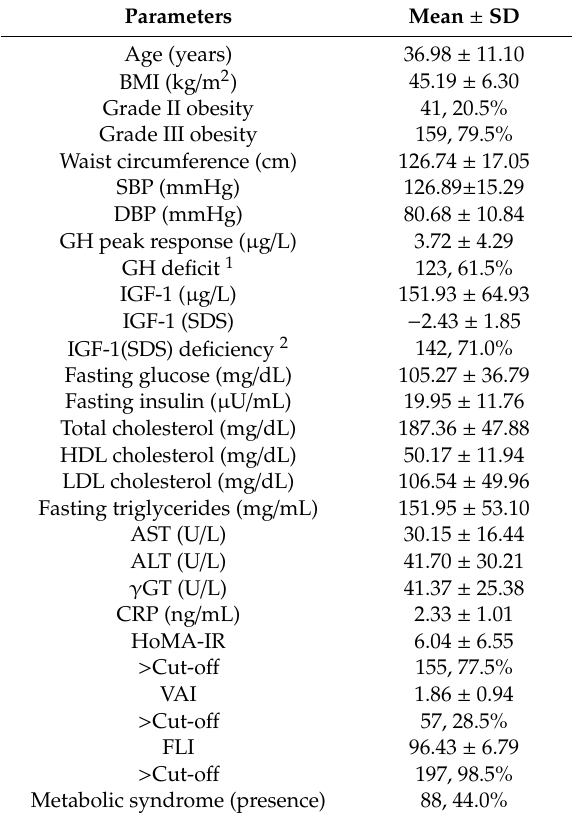
Table 1. Socio-demographic, anthropometric measures and metabolic profile of 200 adult females with obesity included in the